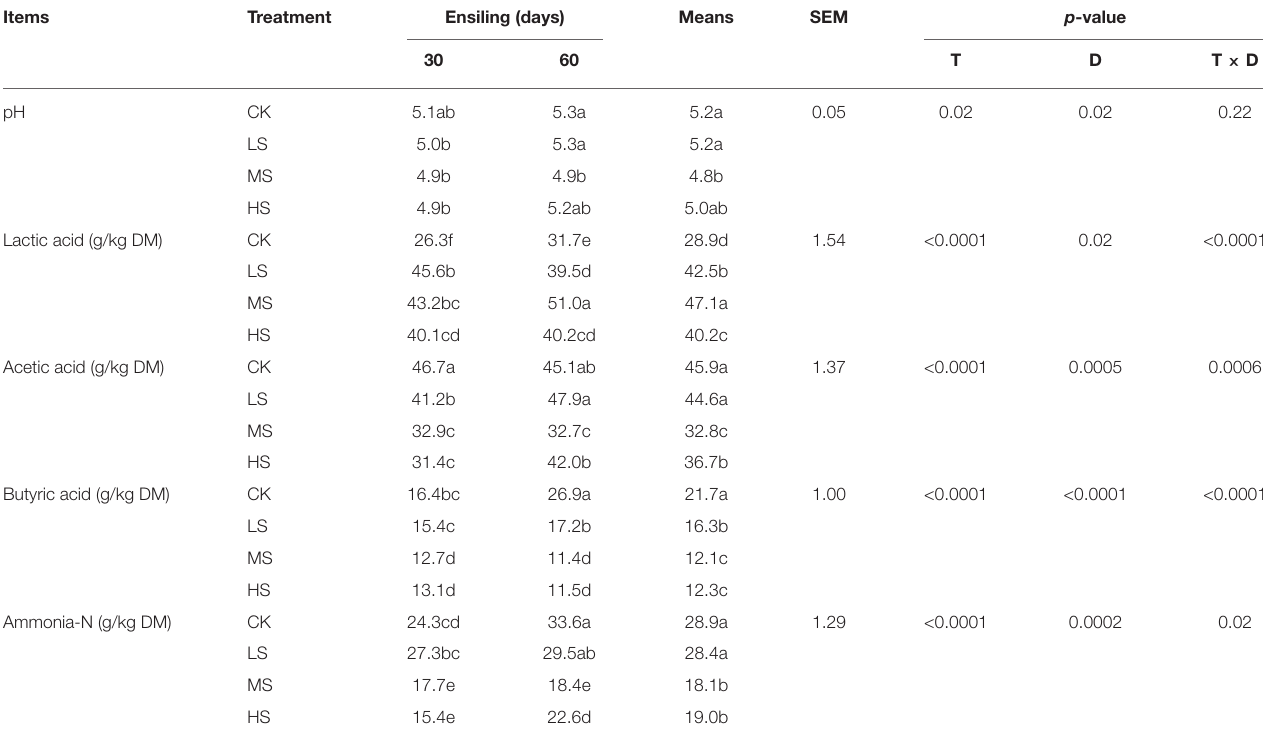
TABLE 3 | Fermentation characteristics of alfalfa silage after 30 and 60 days of